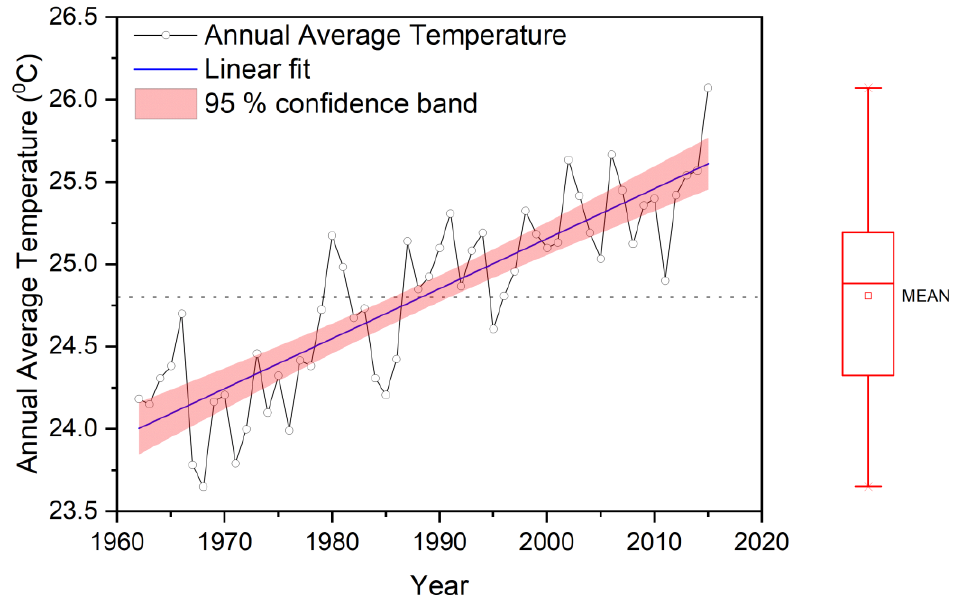
Figure 3. Changes in annual average temperature recorded by the Kaohsiung weather station, 1960– 2016.